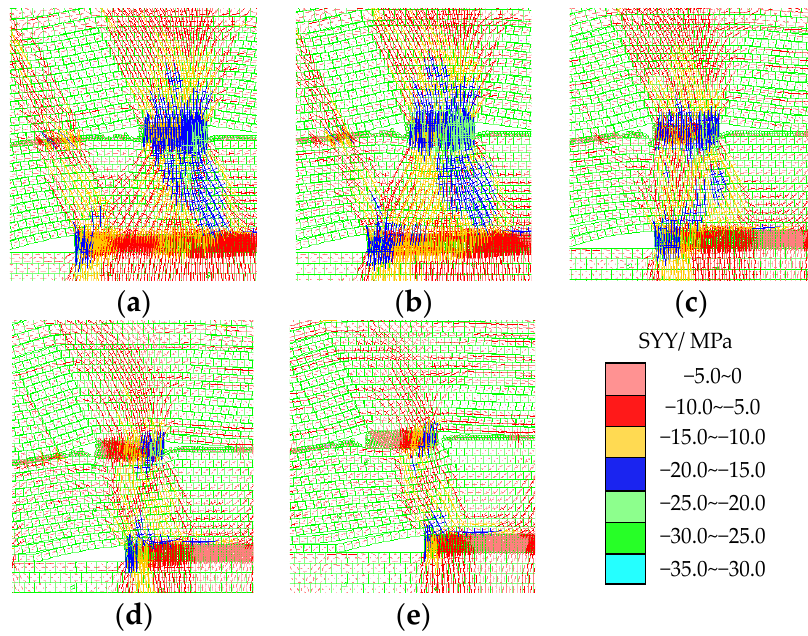
dynamic transformation process between FAP and the concentrated stress of the coal pillar, and results are shown in Figure 18.